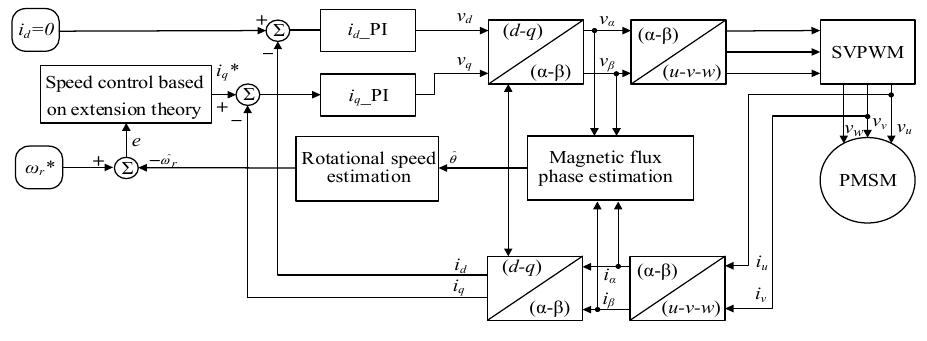
Figure 6. Sensorless speed control architecture [21].